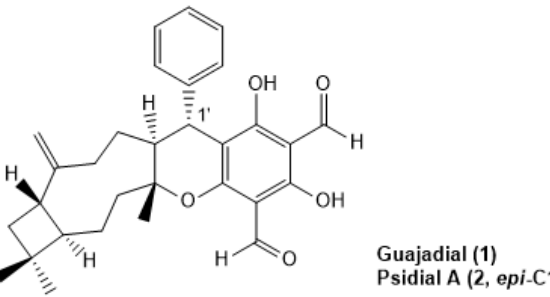
Figure 1. Guajadial and Psidial A structures, meroterpenoids from Psidium guajava L. leaves.